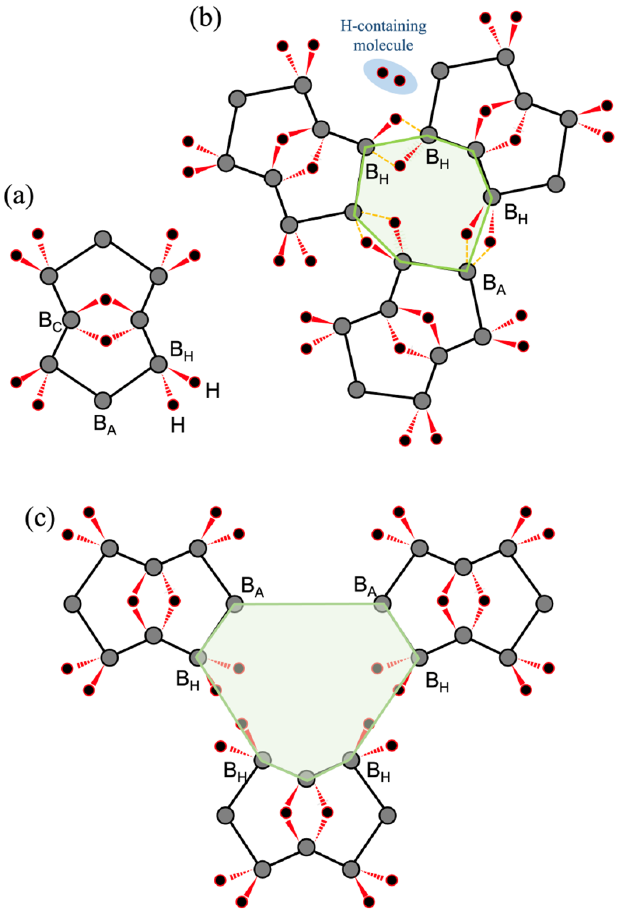
Figure 6. Construction of the borophane layer with the 2:4:6:8:-2H-1,5:1,5- µ H-B 8 H 10 molecules. ( a ) Molecular structures with labels on the different boron sites. ( b ) Building the α -borophane. ( c ) Build- ing the β -borophane. Intermediate seven-membered rings are shaded in green in ( b ) and ( c ).